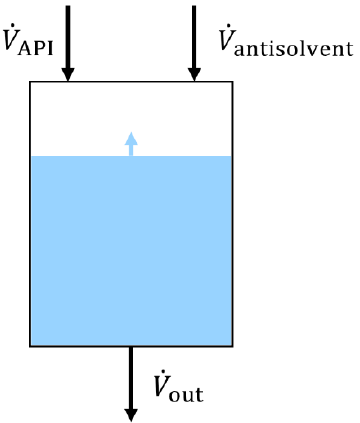
Figure 2. Schematic representation of the MSMPR crystallizer.